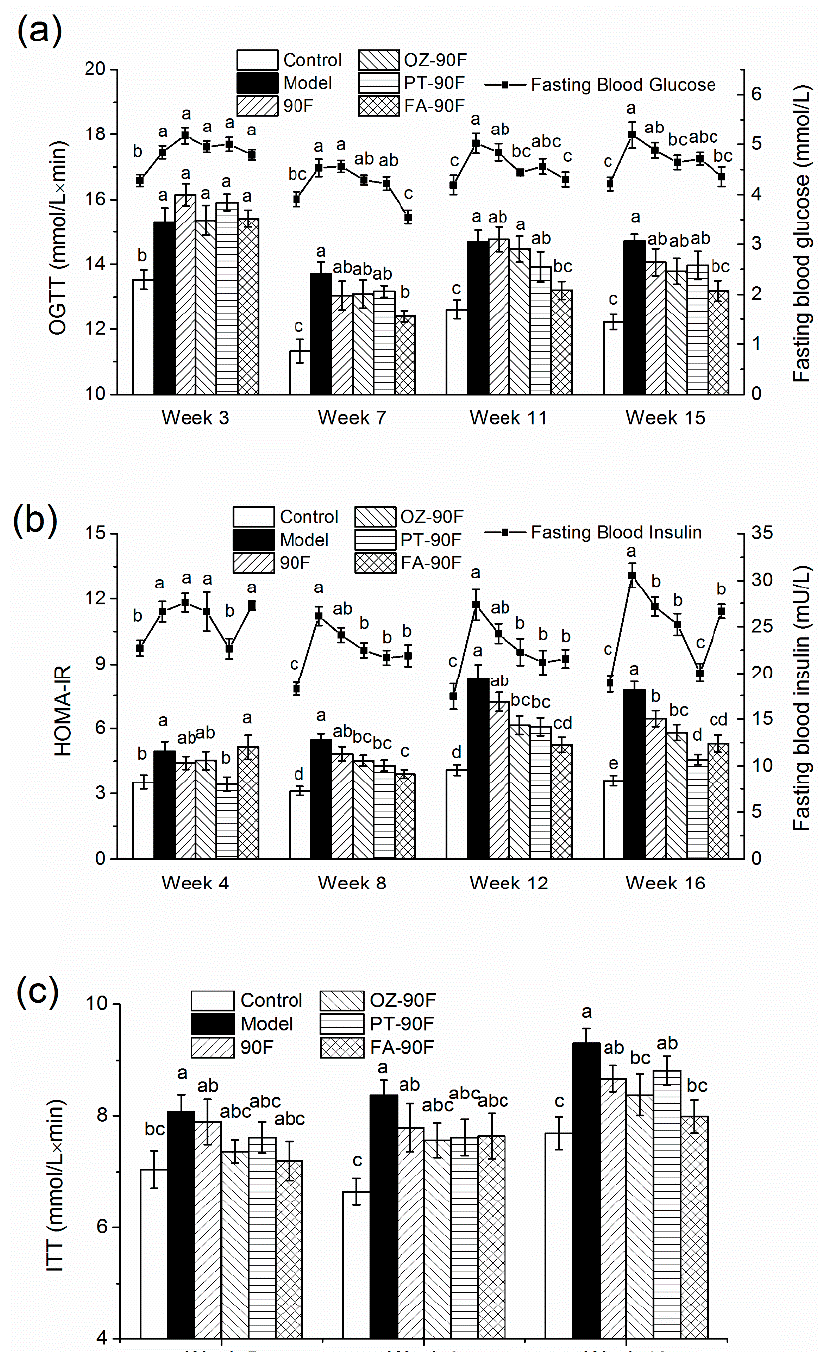
Figure 4. E ff ect of enriched flour upon glucose tolerance, insulin resistance, and insulin tolerance in rats. Fasting blood glucose and the AUC of the oral glucose tolerance test ( a ) were measured at week 3, 7, 11 and 15; Fasting blood insulin and HOMA-IR index ( b ) were measured at week 4, 8, 12 and 16. AUC of insulin tolerance test ( c ) was measured at week 5, 9 and 13. Data are presented as mean ± SEM ( n = 10). Mean values with di ff erent letters from the same week are significantly di ff erent ( p < 0.05). 90F, 90% wheat flour; OZ-90F, γ -oryzanol enriched 90% wheat flour; PT-90F, phytosterol enriched 90% wheat flour; FA-90F, ferulic acid enriched 90% wheat flour.